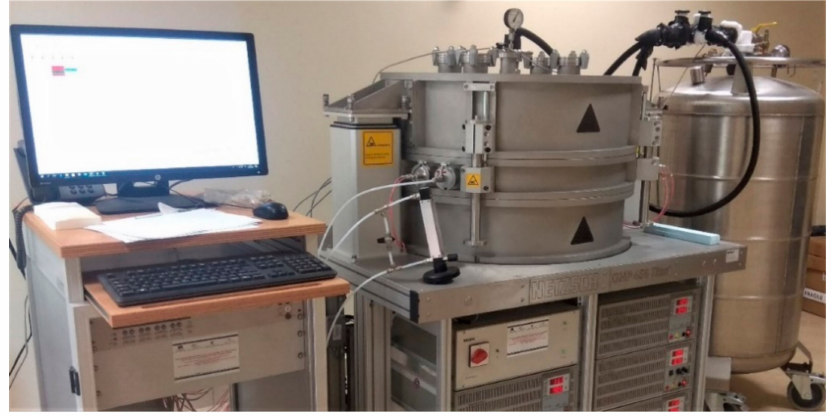
Figure 5. NETZSCH GHP 456 Titan ® system.